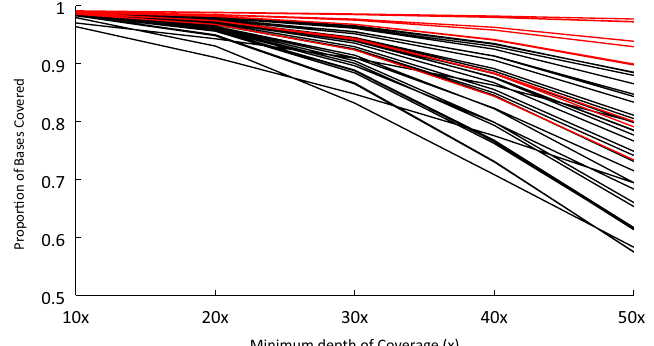
Figure 1. The proportion of bases covered with the exome capture probes. The initial 10 samples are colored in red, with the X axis showing the depth of coverage, which is how many times a nucleotide base is covered starting at a depth of 10x and increasing to 50x.